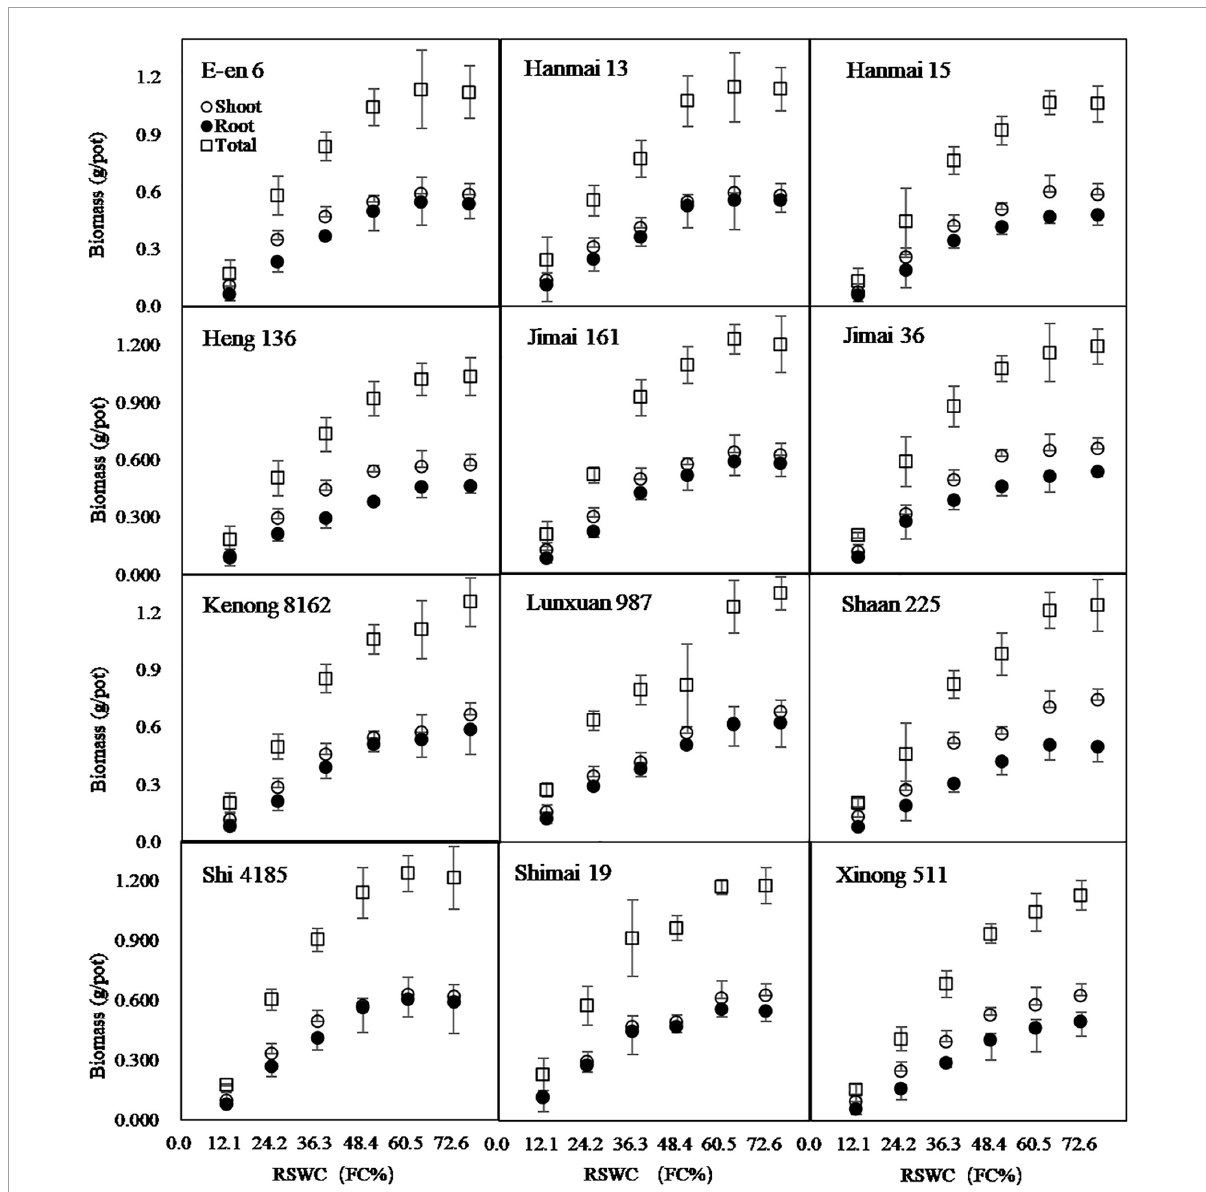
FIGURE3 Growth of shoot, root and total biomass after 33 days cultivation under 6 soil water contents. RSWC , soil water content. FC , field capacity. Data are shown as Mean ± SD, n =